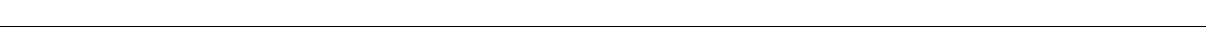
Fig. 4 Characterization of CRISPR-cas9-modi fi ed wt-MCF7 expressing ESR1 Y537S . a Viability assay showing MCF7 Y537S proliferates in the absence of exogenous E compared to wt-MCF7 ( n = 6 technical replicates and three biological replicates). Mean growth at day12 ± SEM relative to day 0. b Immunoblotting showing alterations in the expression of ESR1, PGR, CTSD, TFF1, and RARA. c Overlap between wt-MCF7 and MCF7 Y537S ESR1 binding sites in the absence of E and d corresponding heatmap. The heatmap depicts binding peak intensities that are common or different between the wt-MCF7 and MCF7 Y537S . The window represents ± 5 kb regions from the center of the binding event. e Comparison of the average read count between wt-MCF7 and MCF7 Y537S in the absence of E showing peak af fi nity in both cell lines (left) and those binding sites only signi fi cant in MCF7 Y537S (right) ( q -value < 0.05). f Bar chart showing the genomic distribution of ESR1 binding sites across the genome in both cell lines. g Volcano plot showing changes in gene expression by RNA-seq as a result of differential ESR1 Y537S binding in MCF7 Y537S showing increased expression of estrogen-regulated and proliferation- associated genes. h Venn-diagrams showing intersect between wt-MCF7 and CRISPR generated MCF7 Y537S ChIP-seq peaks in response to ethanol (ETOH) or estradiol (E) and intersect between SUM44-LTED and MCF7 Y537S in the absence of